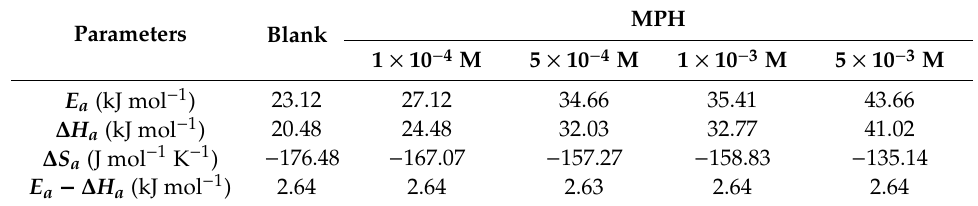
Table 5. Corrosion kinetic parameters for mild steel in 1.0 M HCl in the presence and absence of MPH.